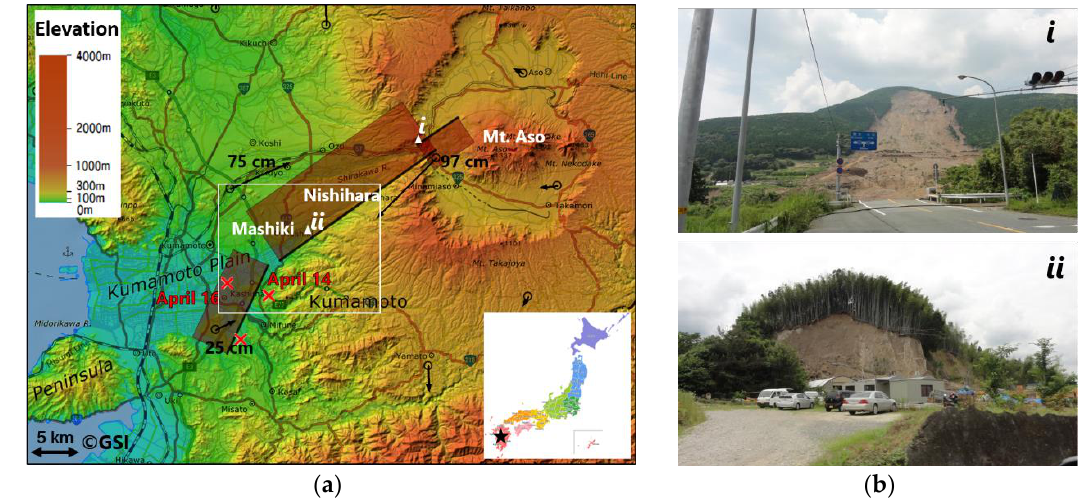
Figure 1. ( a ) Location of causative faults and GNSS stations in the 2016 Kumamoto Earthquake. The background is an elevation map in the rainbow color. ( b ) Two ground photos of landslides taken in field surveys by F. Yamazaki. Their locations are shown in ( a ).